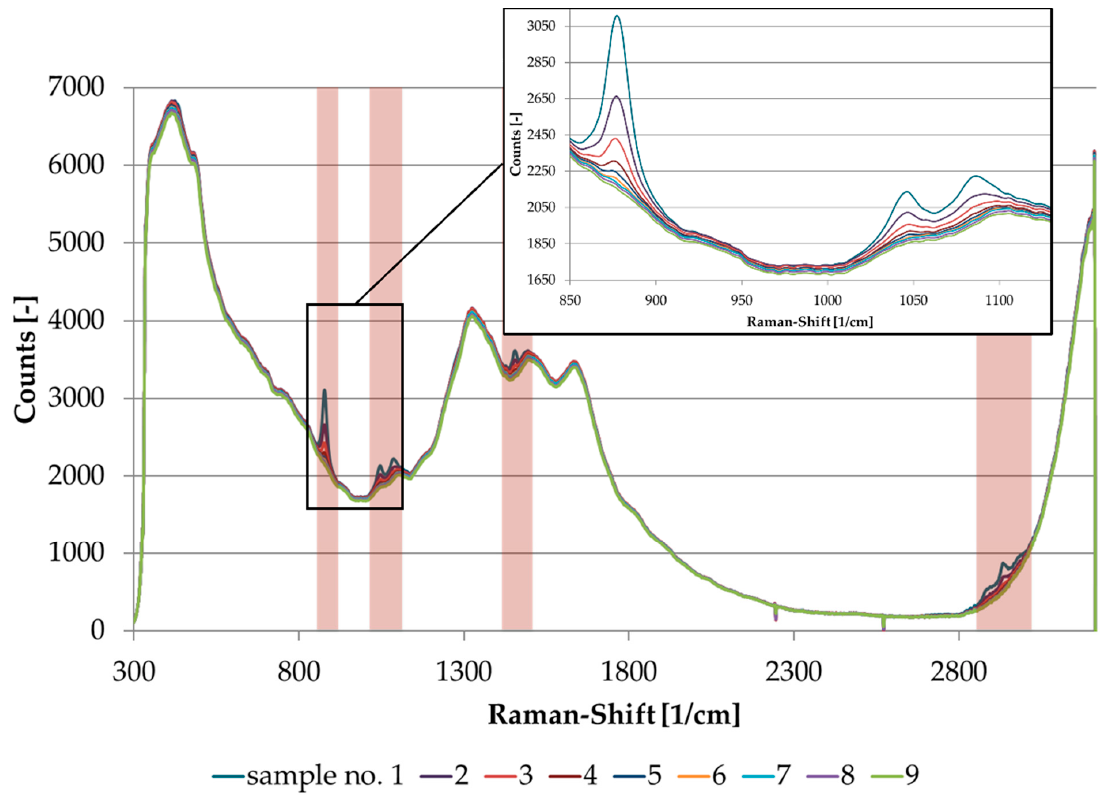
Figure 4. Raman spectra of ethanol dilution series (sample number 1–9).